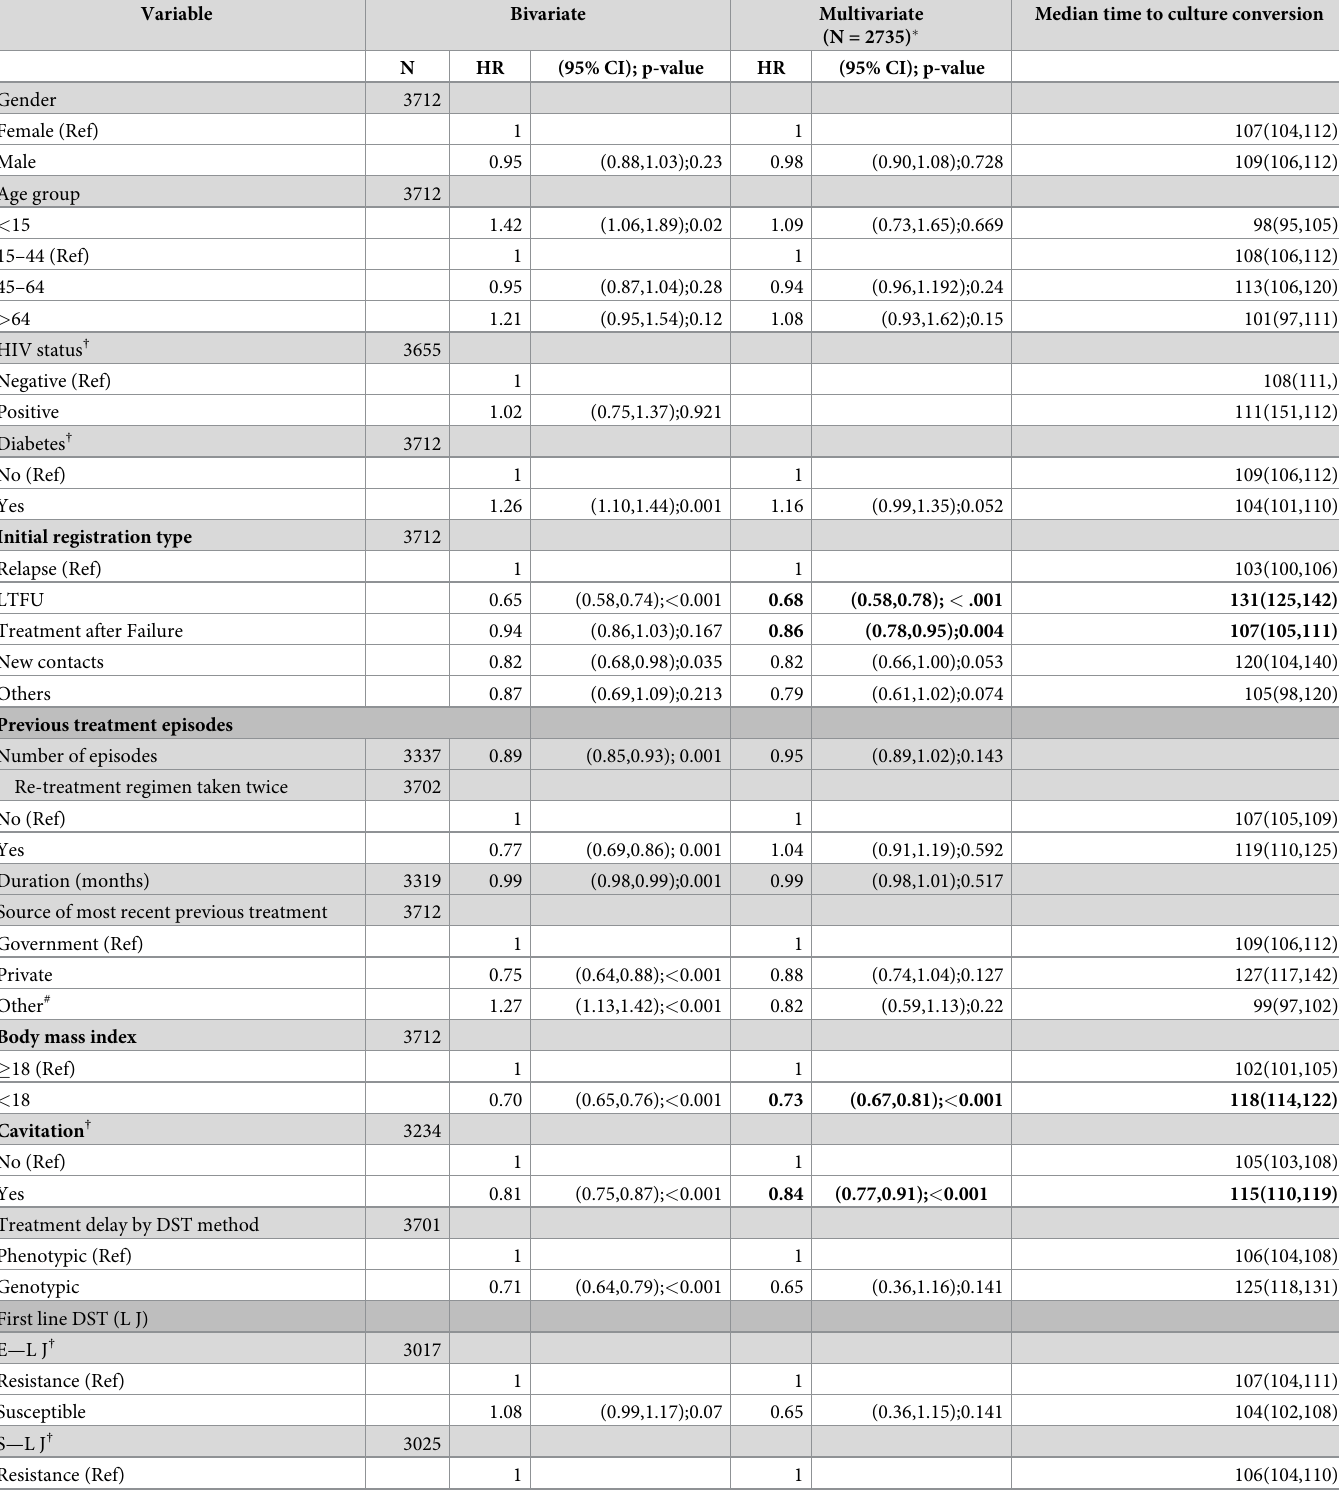
Table 2. Bivariate and multivariate survival models for time to culture conversion. (Note: HR value < 1 means lower chances of and longer time to culture conversion (positive event/outcome). Variable Bivariate Multivariate